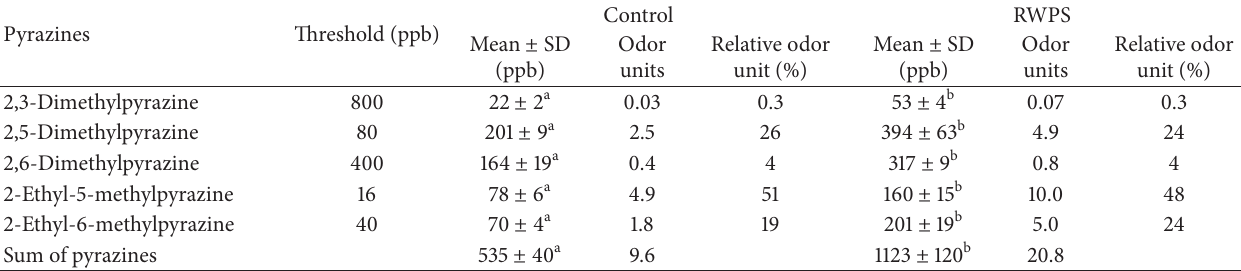
Table 2: Concentration (mean ± SD) of five pyrazines (ppb) in barbecued beef patties without (control) and with red wine pomace seasoning (RWPS) ( a )